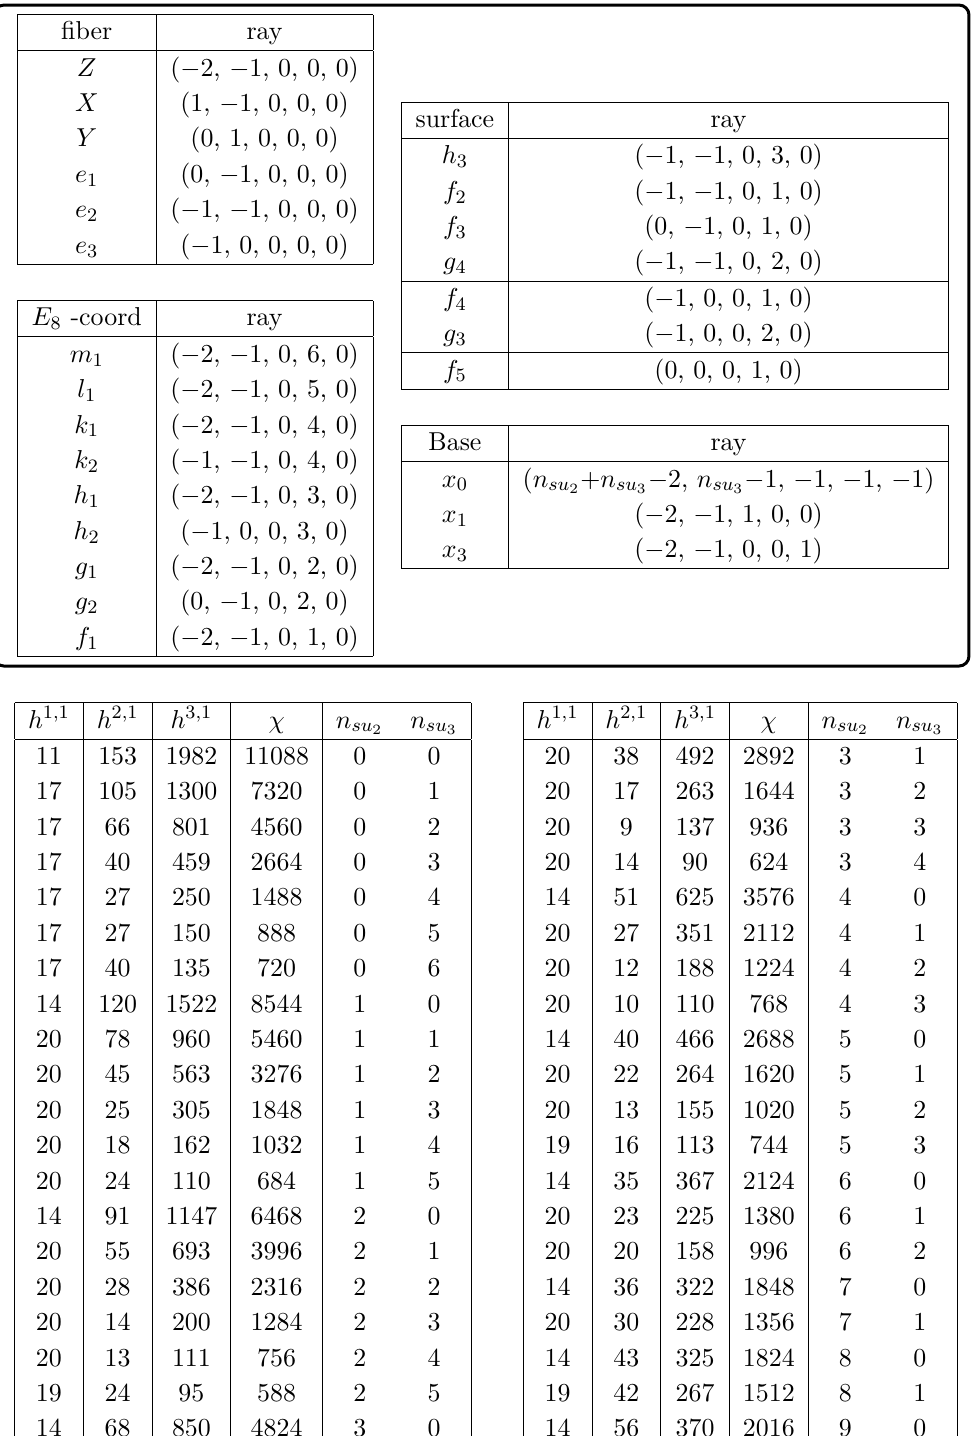
, n su ) that leads to smooth elliptic four-fold 3 2